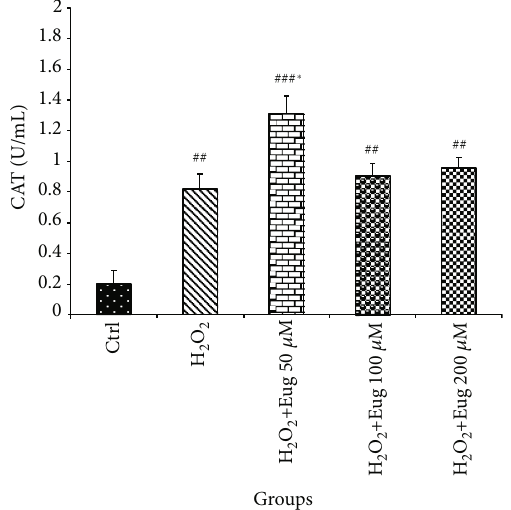
Figure 4: E ff ects of H O and eugenol on the CAT level of islets of 2 2 Langerhans. Data are expressed as the mean ± SE , n = 6 (7 islets in each sample). ## P < 0 : 01 and ### P < 0 : 001 signi fi cantly di ff erent with the control group; ∗ P < 0 : 05 signi fi cantly di ff erent with the H O group. Eug: 2 2